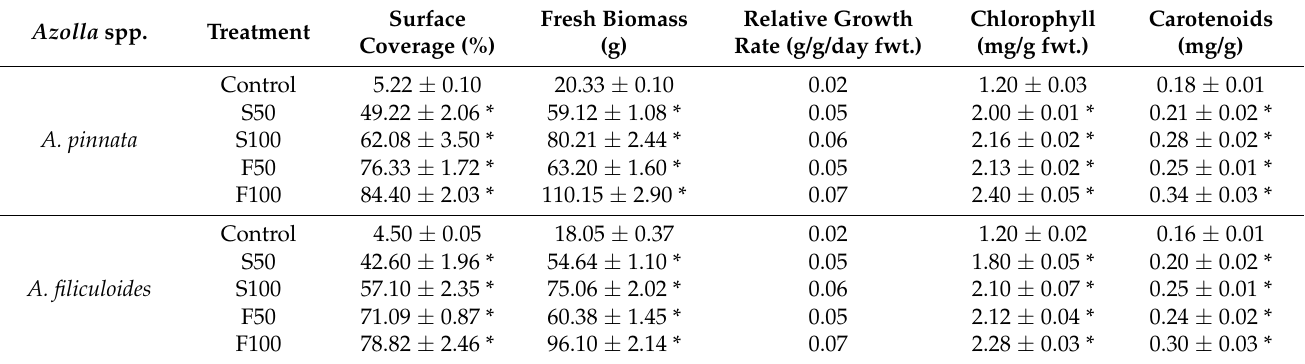
Table 3. Growth and biochemical changes in two Azolla spp. cultivated in different treatments of MFW. Azolla